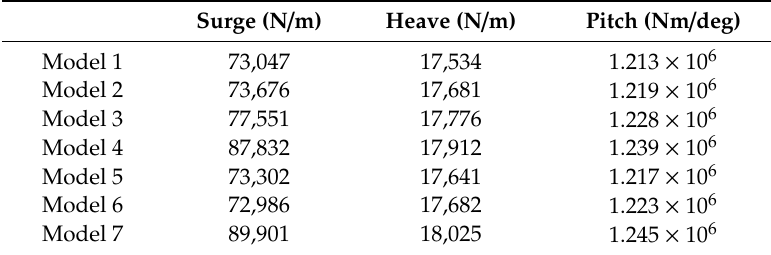
Figure 5. Restoring forces as a function of the displacement for determining the stiffness of the system in ( a ) surge direction; ( b ) heave direction; and ( c ) pitch direction. Table 6. Mooring sti ff ness of each